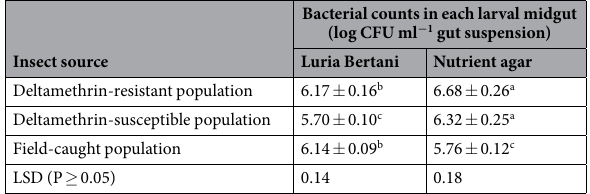
Table 1. Counts of bacteria cells hosted by the midgut of diamondback moth, Plutella xylostella . Column values followed by same letters are not significantly different from each other at